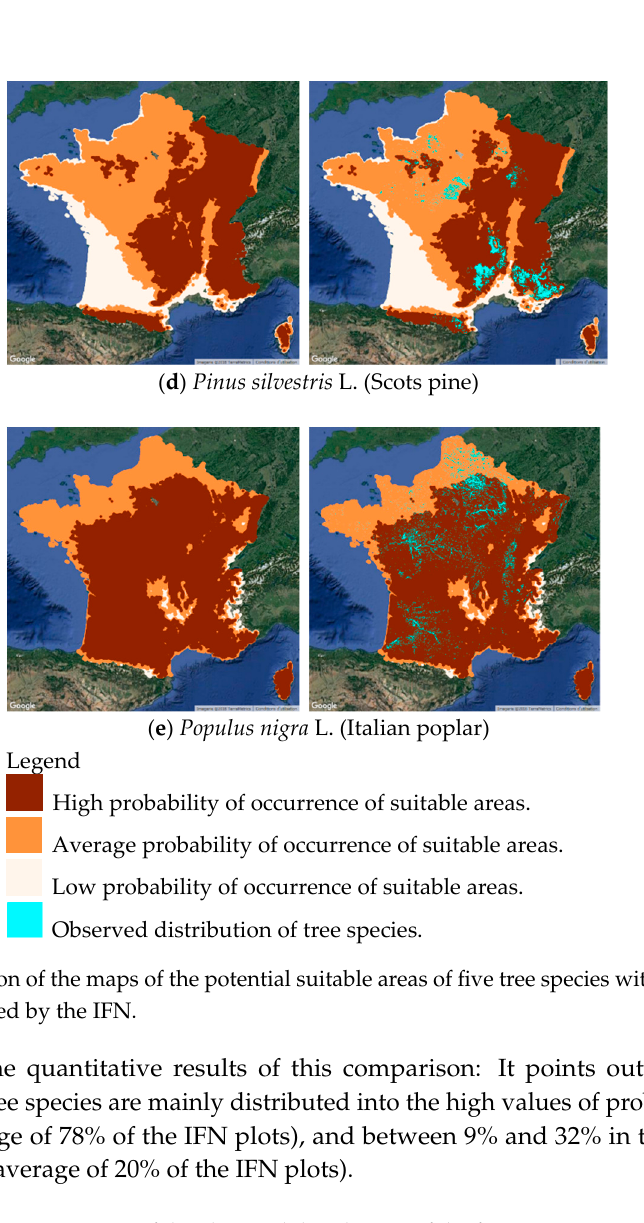
Table 1. Quantitative comparison of the observed distribution of the five tree species with the potential distribution of their suitable areas in France for the current climate. Abies alba Amount of IFN plots= 3931 Proba.